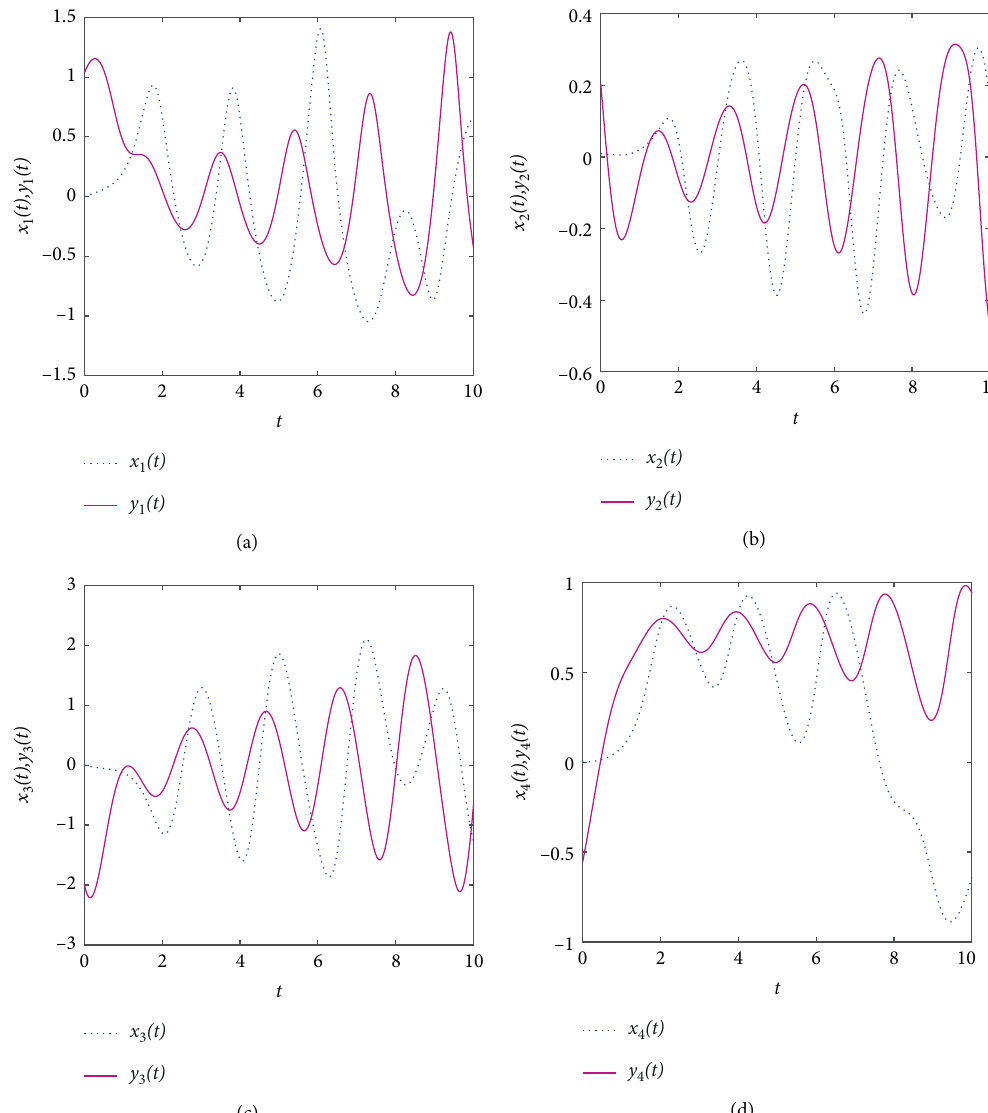
Figure 3: Dynamical behaviors of the drive system (13) and the response system (14) without periodic intermittent controller (15), where , (a) , ; (b) , ; (c) , ; (d) , 𝛼 = 0.985 𝑥 1 (𝑡) 𝑦 1 (𝑡) 𝑥 2 (𝑡) 𝑦 2 (𝑡) 𝑥 3 (𝑡) 𝑦 3 (𝑡) 𝑥 4 (𝑡) 𝑦 4 (𝑡)